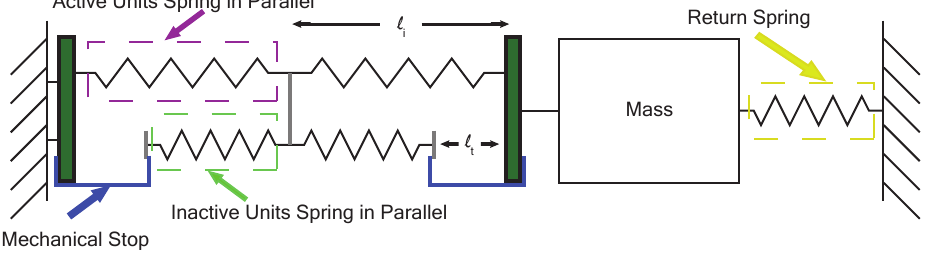
Figure 7. Horizontal oscillatory